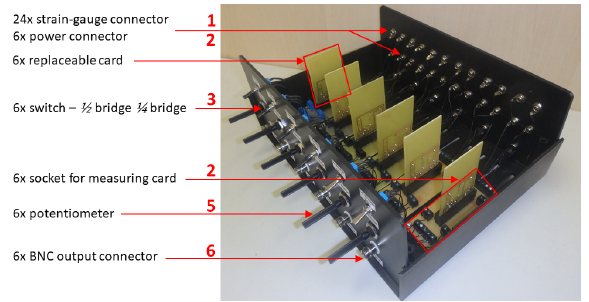
Figure 3. Internal distribution of Strain-gauge mea- surement